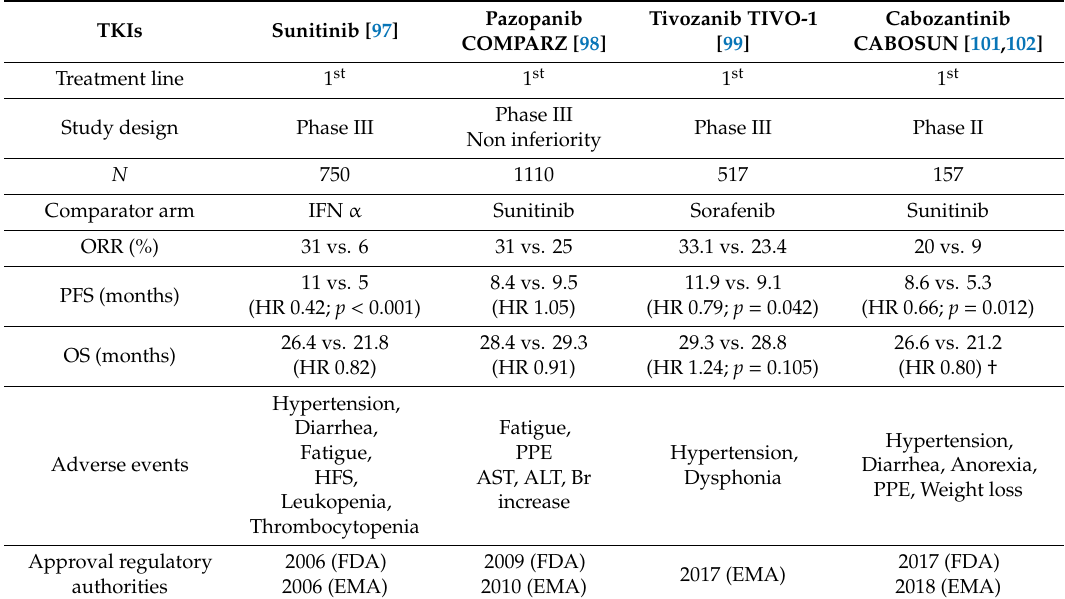
Table 1. Tyrosine kinase inhibitors (TKIs) evaluated in phase II and III clinical trials in the first line setting. † Updated analysis, after a median follow up of 34.5